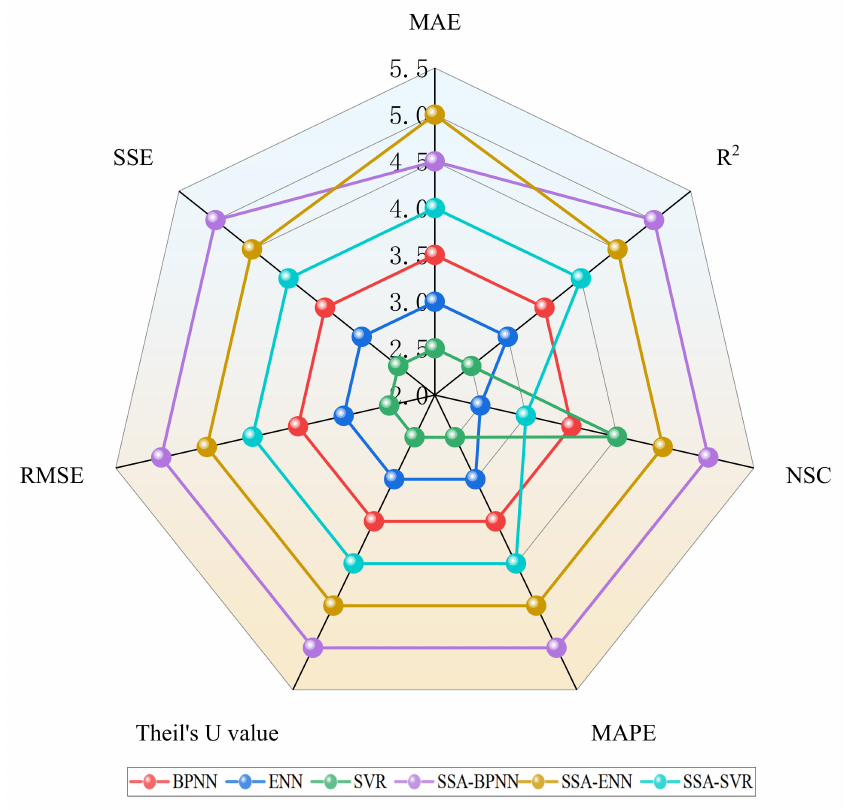
Figure 18. Radar chart of model scores corresponding to each